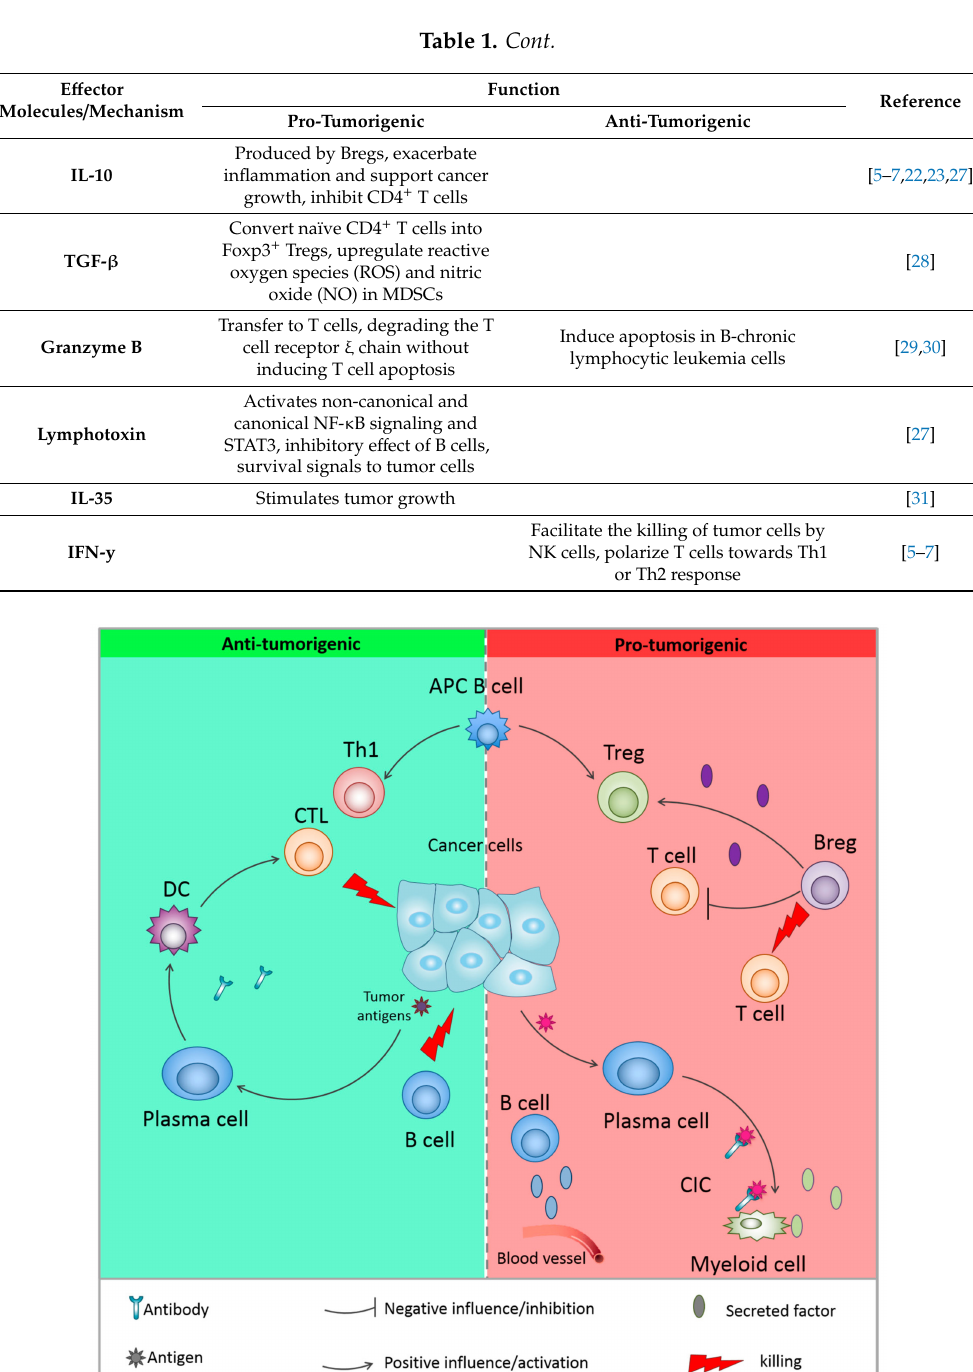
Figure 1. Dual role of B cells in the tumor microenvironment. B cells can have anti-tumor activities through the recognition of tumor-specific antigens and antibody production, antigen presenting cell (APC) function or direct killing of cancer cells. They can also be associated to pro-tumorigenic activities, through activation of myeloid-derived suppression cells (MDSC), production of pro-tumorigenic cytokines and activation of immunosuppressive regulatory T cells. The pro-tumoral activity is mainly mediated by regulatory B cells. DC = dendritic cells; CTL = cytotoxic T cells; Th1 = type 1 T helper cell; APC = antigen presenting cell; CIC: circulating immune